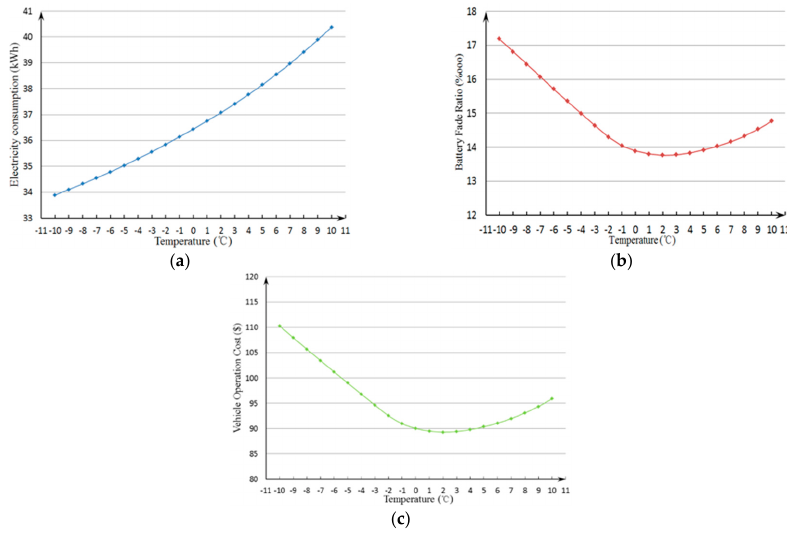
Figure 10. When ambient temperature T 0 is − 10 ◦ C, driving range L is 20 km, SOC range of charging is 20%~80%, and vehicle is preheated to different temperatures, after vehicle operation, corresponding ( a ) electricity consumption, ( b ) battery fade ratio and ( c ) vehicle operation